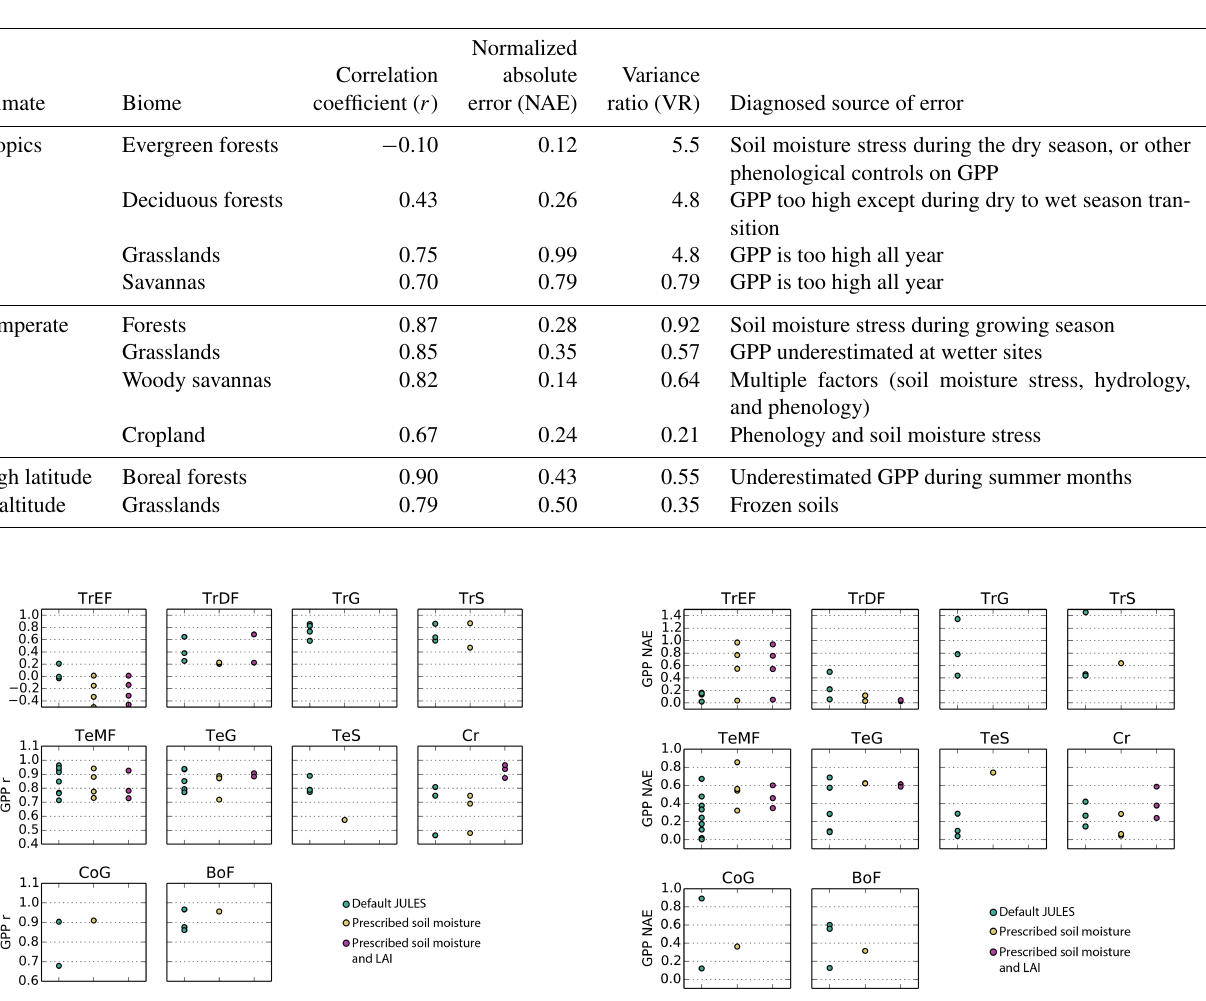
Table 3. Summary of model performance for GPP with no prescribed data. The statistics are averages for each biome: Pearson’s correlation coefficient ( r ), normalized absolute annual error (NAE), and variance ratio (VR).